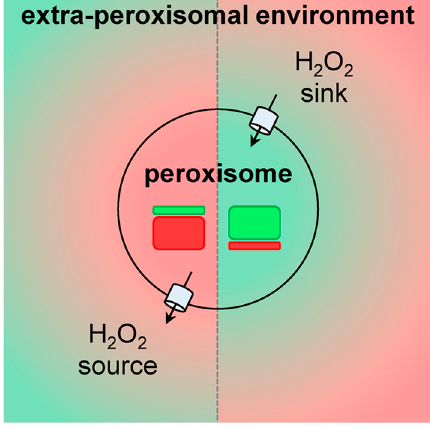
Figure 2. Peroxisomal hydrogen peroxide (H 2 O 2 ) metabolism and its potential effects on intracellular H 2 O 2 gradients. H 2 O 2 -producing and -degrading enzymes are depicted as red and green rectangles, respectively.